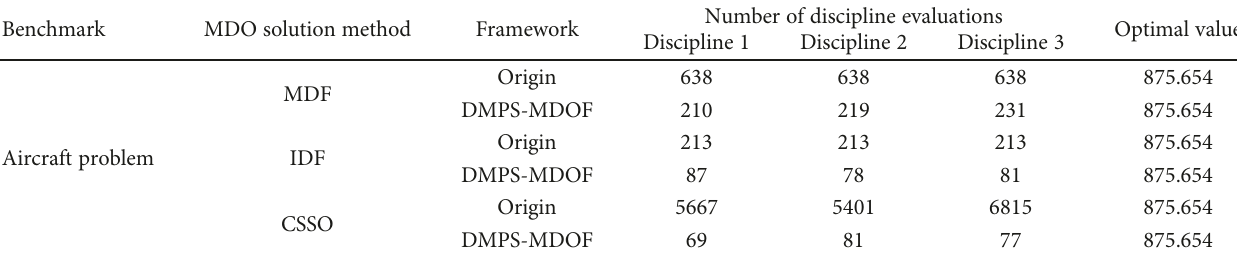
Table 5: Result comparison of the aircraft